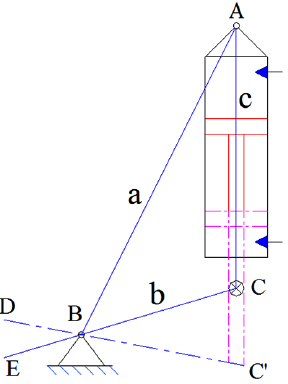
Figure 2. Structure diagram of an electrohydraulic servo actuator in parallel form.